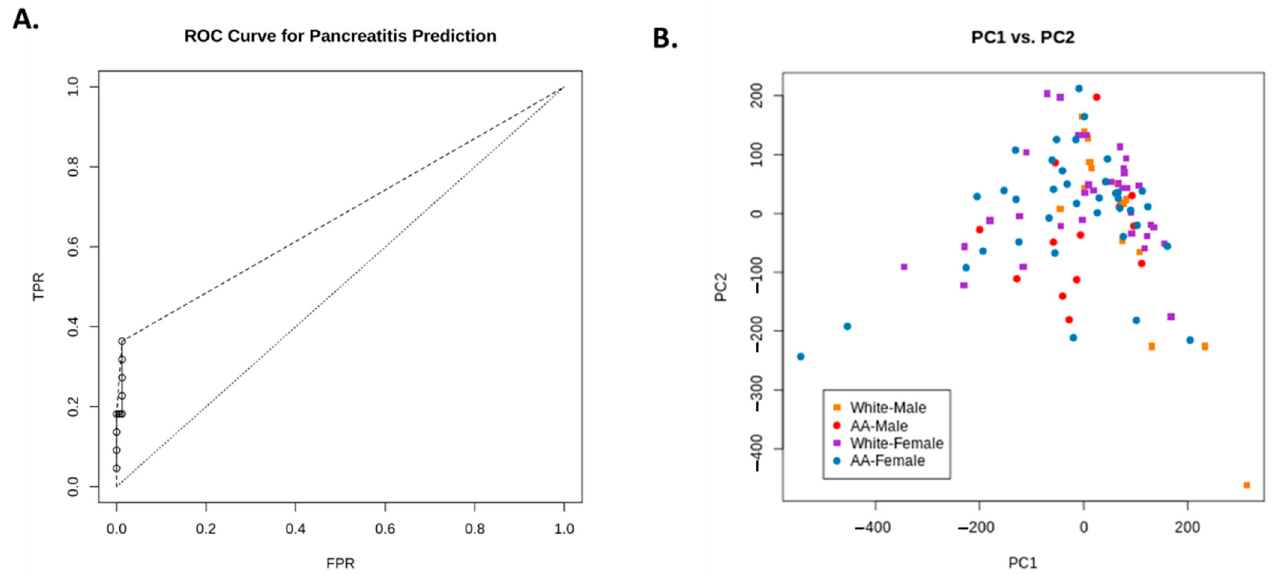
Figure 3. ( A ) shows the receiver operating characteristic (ROC) curve used to evaluate the performance of the classifier. Data covering the entire range of false positives is missing, so the remaining range is linearly interpolated (shown as a dashed line). The true-positive rate (TPR) increase dramatically with increases false-positive rate (FPR). The broken line shows the performance of the classifier given random chance. ( B ) shows the PCA with the best fit based on PC1 and PC2—most patients fell into a single cluster.